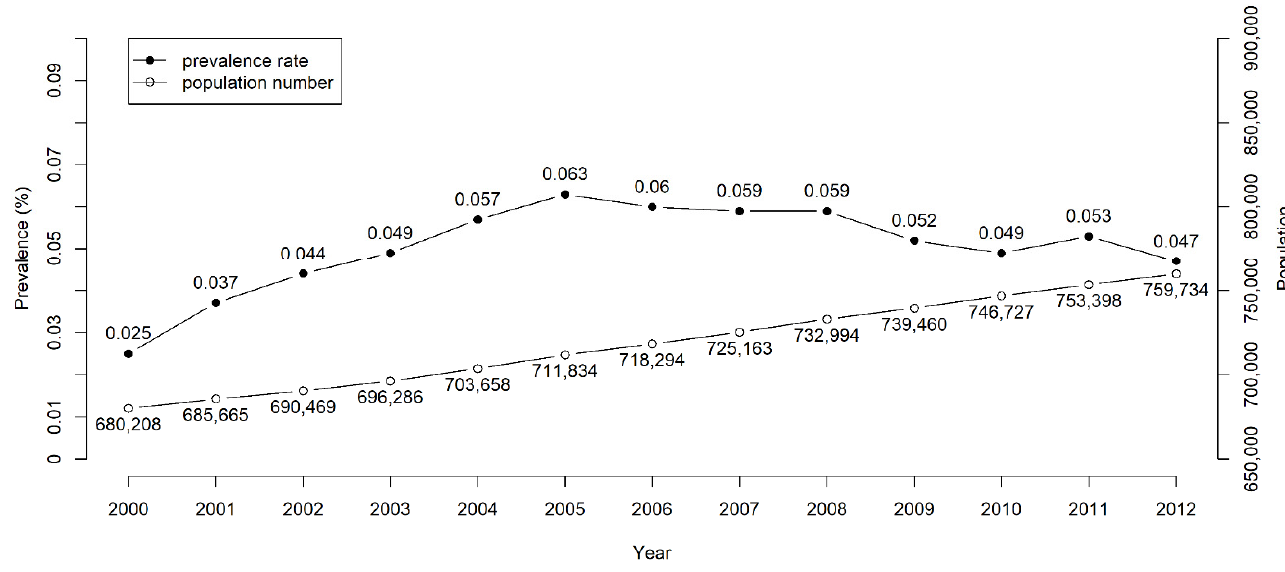
Figure 2. Prevalence rates and numbers of long-term nasogastric tube placement in Taiwan from 2000 to 2012. Table 1. The characteristics of patients with nasogastric tube placement with different main cause.